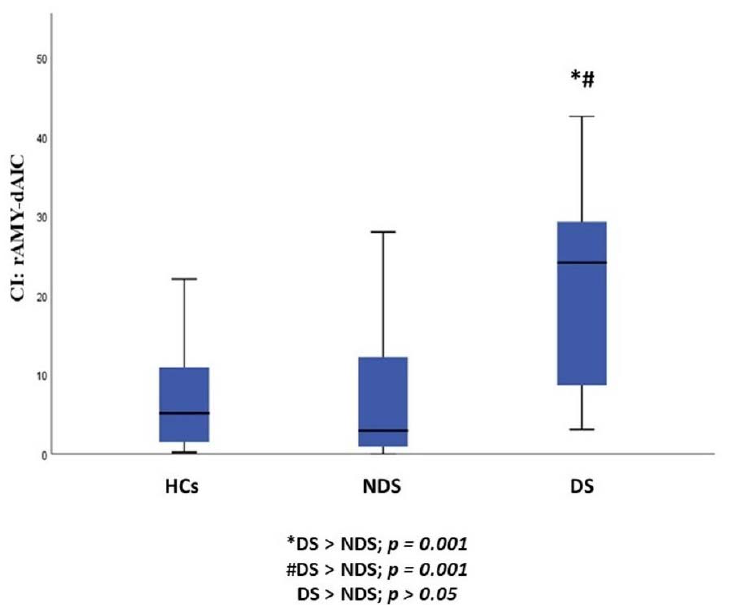
Figure 2. Group differences between DS, NDS and HCs in the CI of the rAmy-daIC pathway. HCs: healthy controls; DS: subjects with deficit schizophrenia; NDS: subjects with non-deficit schizophrenia CI: connectivity index; rAmy: right amygdala; daIC: dorsal-anterior insular cortex.